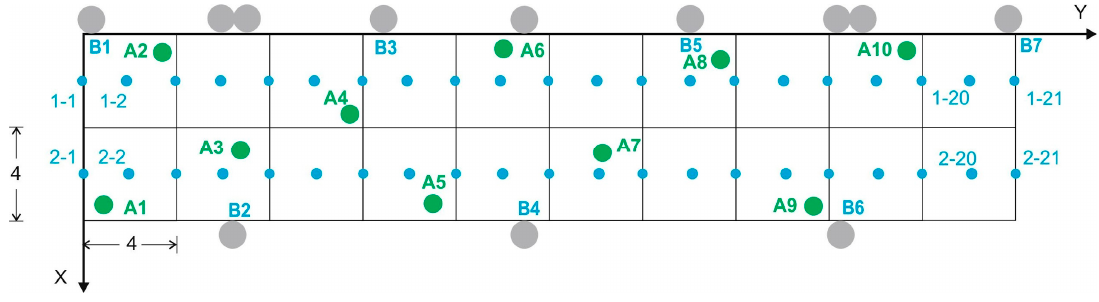
Figure 17. Grid with the initial 22 reference points (only odd points) and with the 42 points used later. The 10 target points are also displayed.